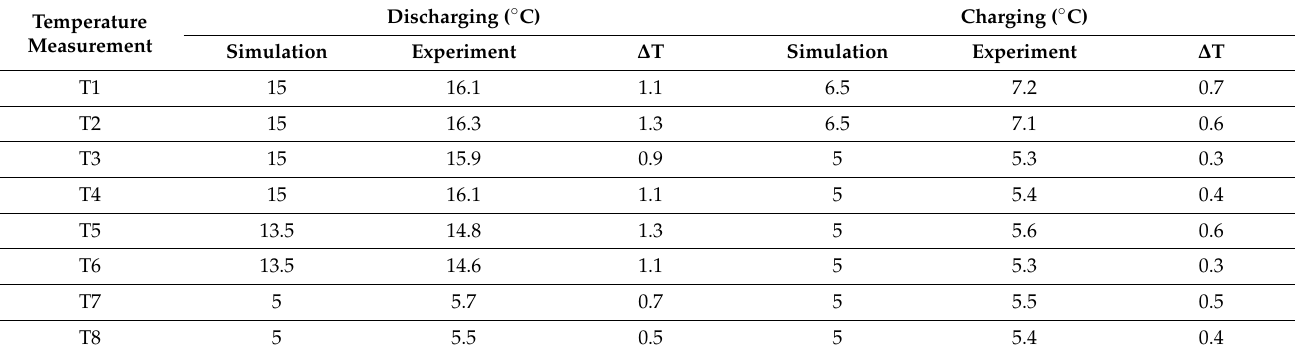
Table 3. Simulation validation with lab-scale experiment at 1